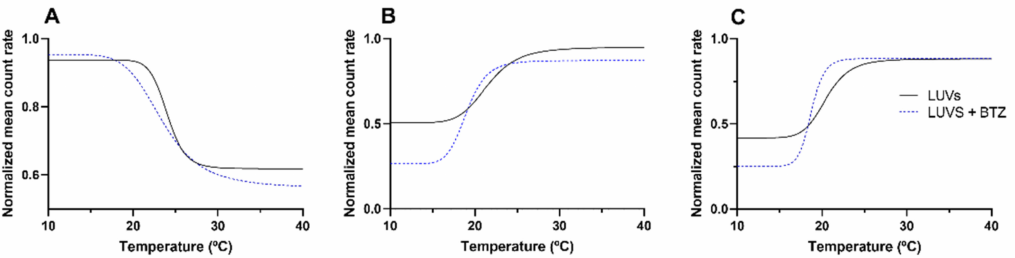
Figure 5. Non-linear regression (Equation (6)) of the normalized count rate with increasing tempera- tures with and without BTZ (400 µ M), ( A ) DMPC, ( B ) DMPC:Chol:SM pH 6.5, and ( C ) DMPC:Chol:SM pH